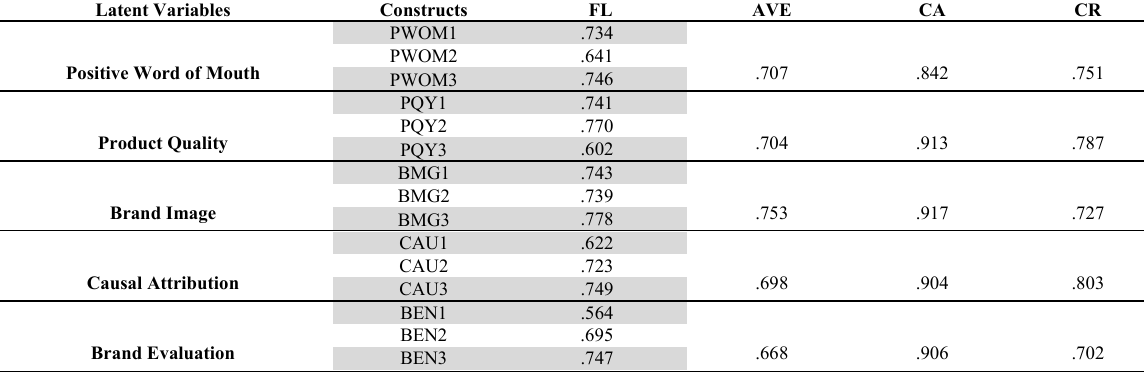
Convergent Validity and Construct